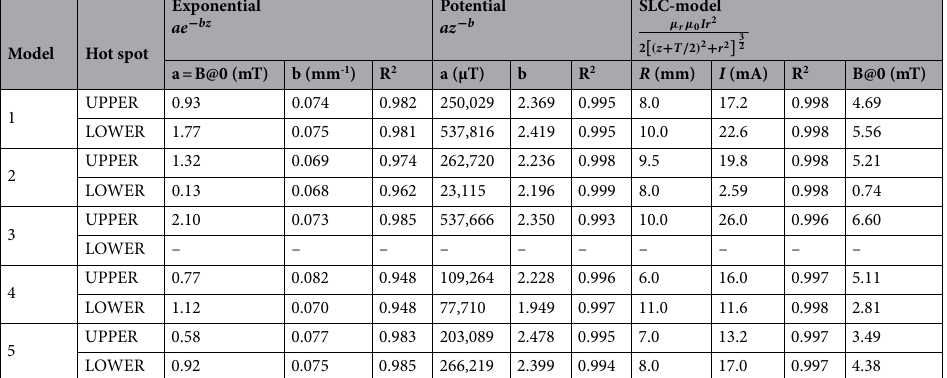
Table 2. Parameters of the regression used to fit the measurements: exponential, potential, and our SCL- model. The potential fitting predicts B@0 → ∞, so it is not consigned in the table.